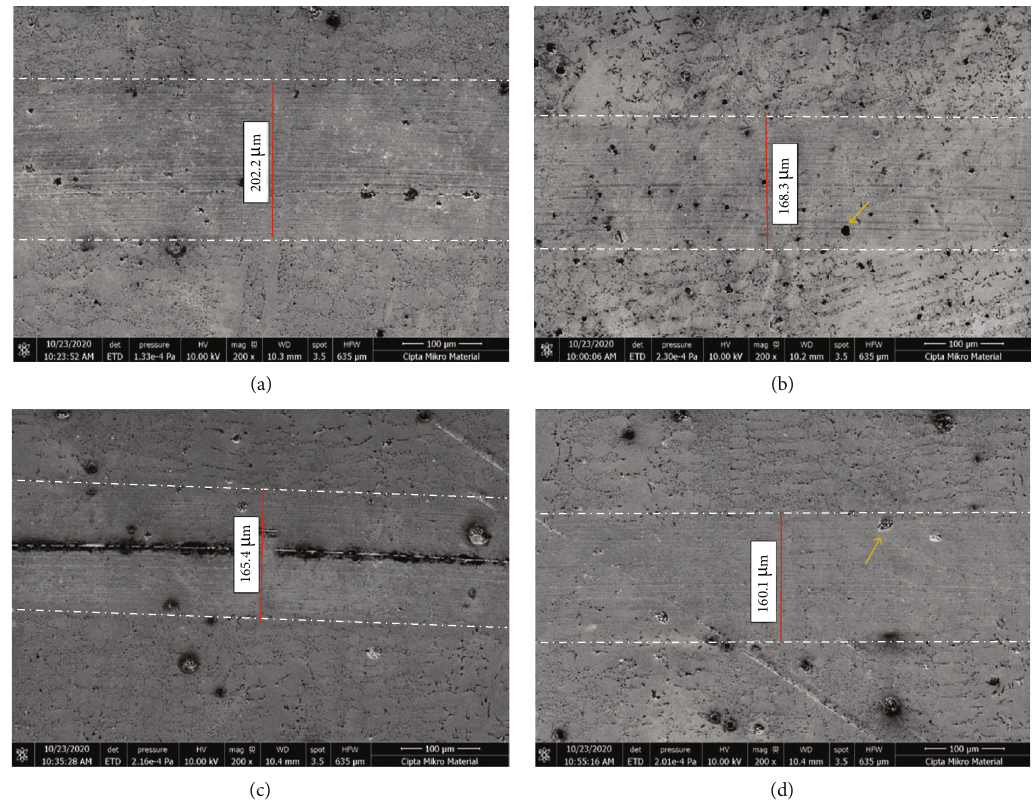
Figure 9: The SEM micrographs of wear scar width (distance between two white dash-dot lines) on the surface of grey cast iron disk after the friction test using (a) PO, (b) N1S2, (c) N1S3, and (d) N2S4. Brown arrows indicate black